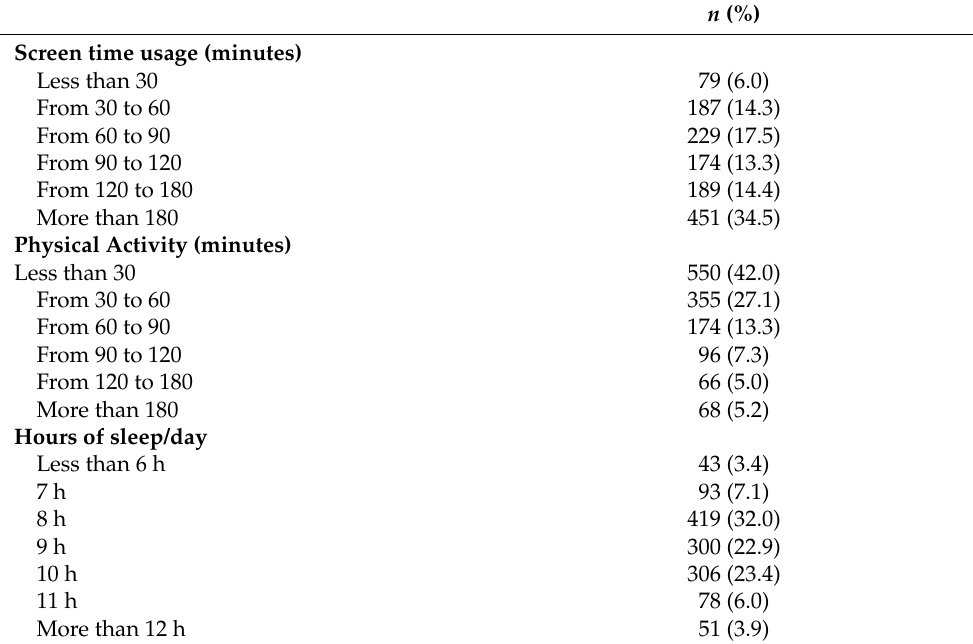
Table 3. Children’s patterns of daily screen time usage, daily physical activity, and sleep